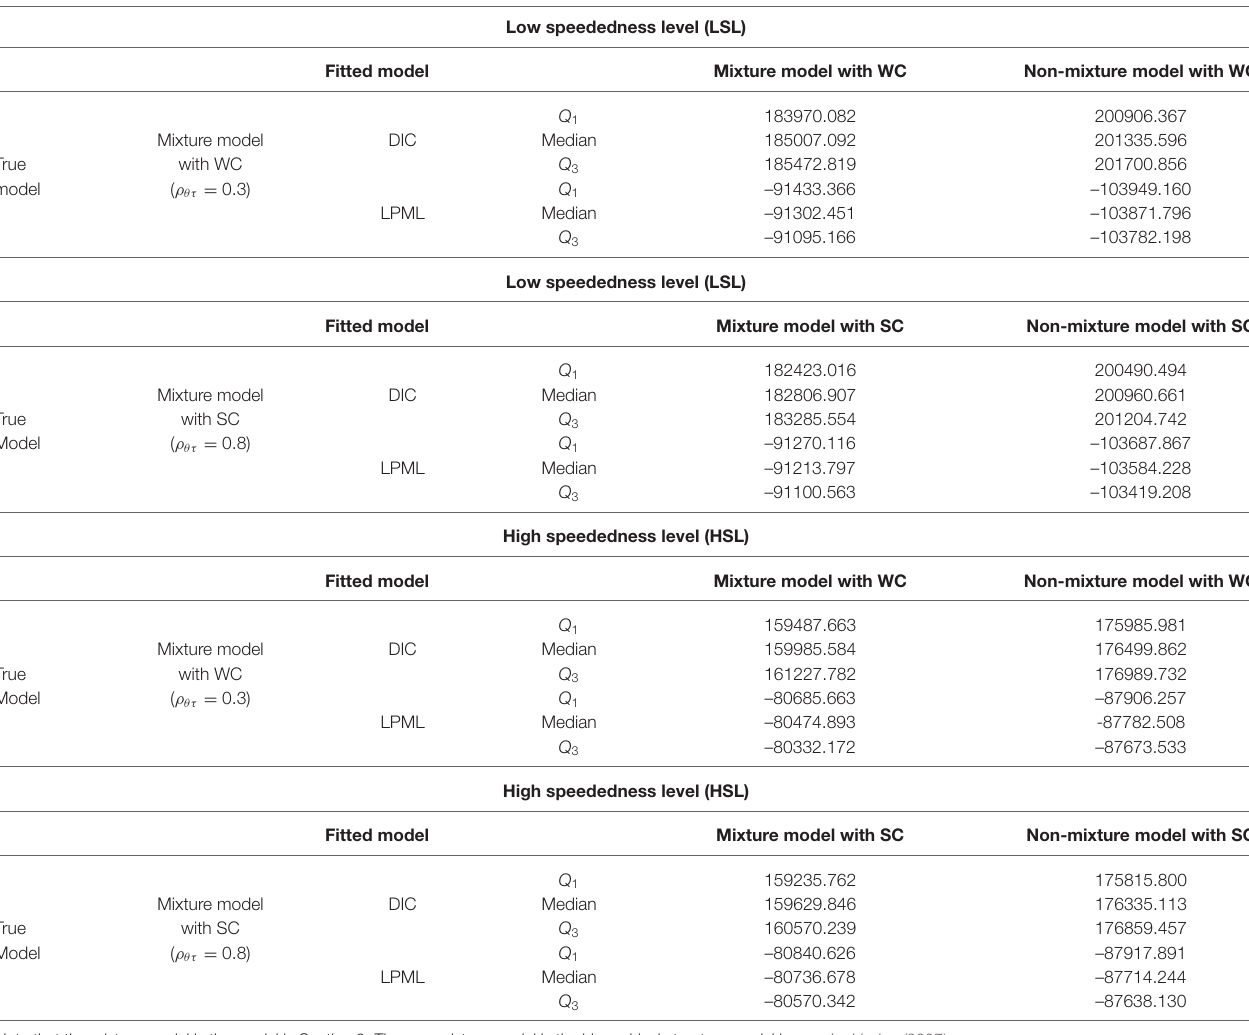
TABLE 3 | The results of Bayesian model assessment in simulation study